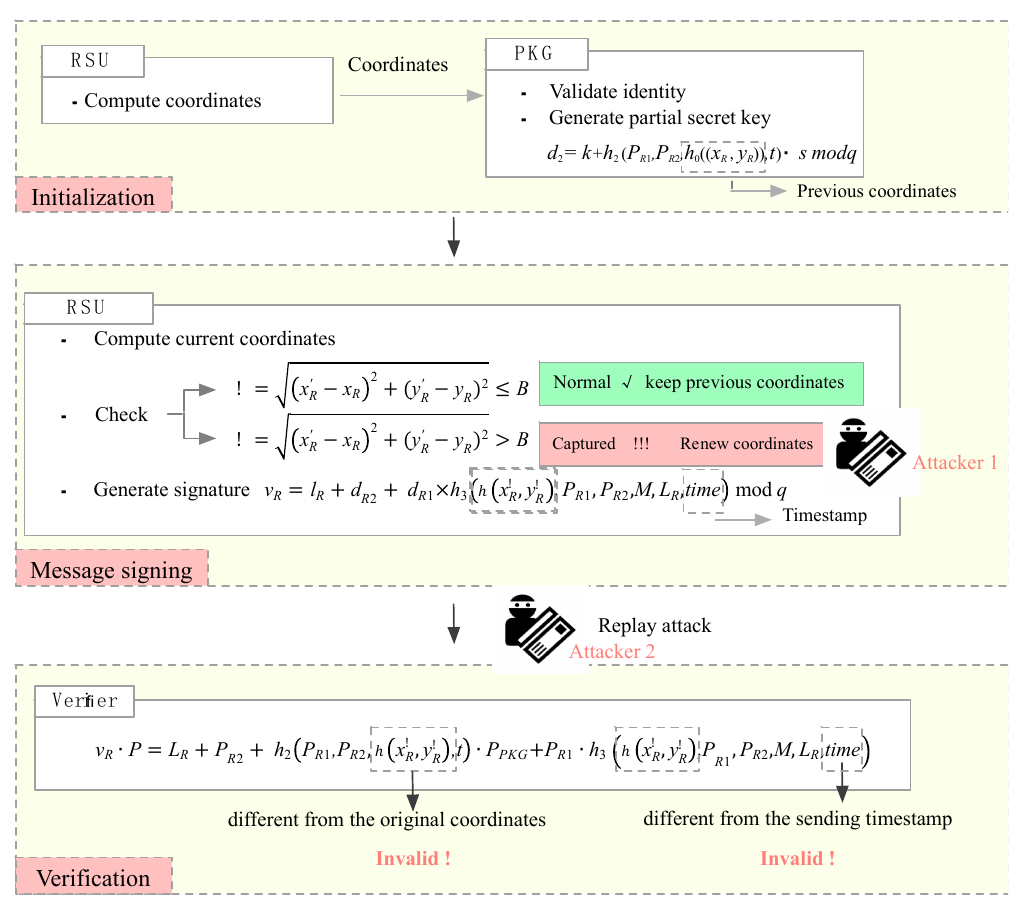
Figure 7. Freshness of timestamp and coordinates.